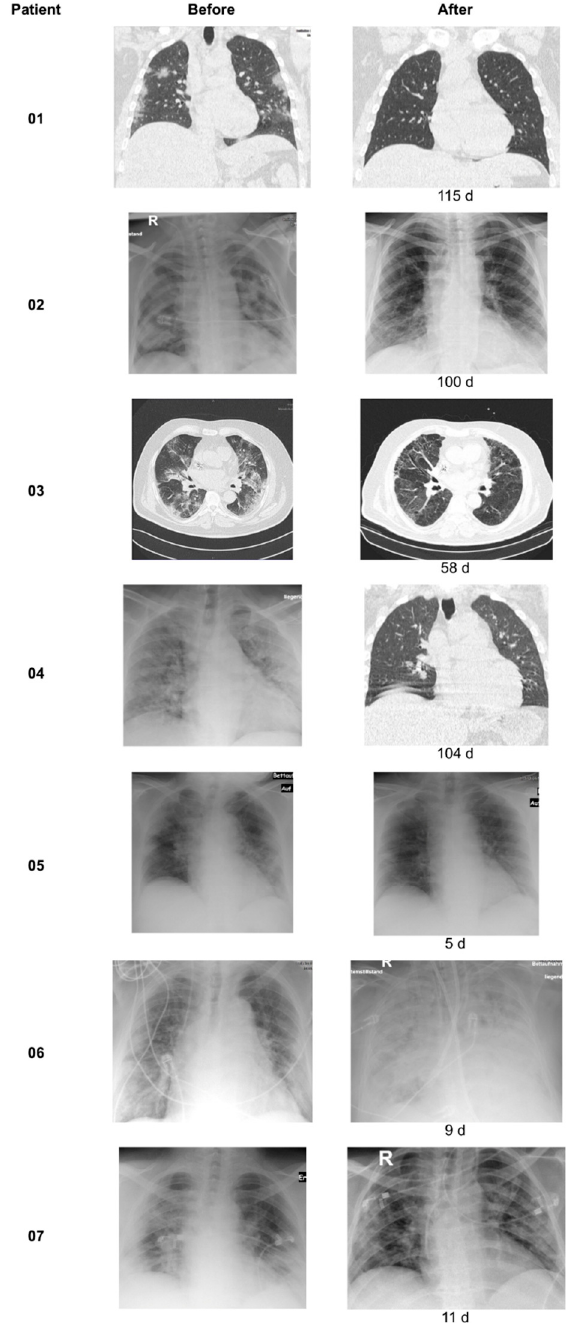
Figure 2. X-ray/CT chest scans. Chest scans were performed before and after treatment/as follow up. The time (days) between the different scans is indicated at the second chest scan.